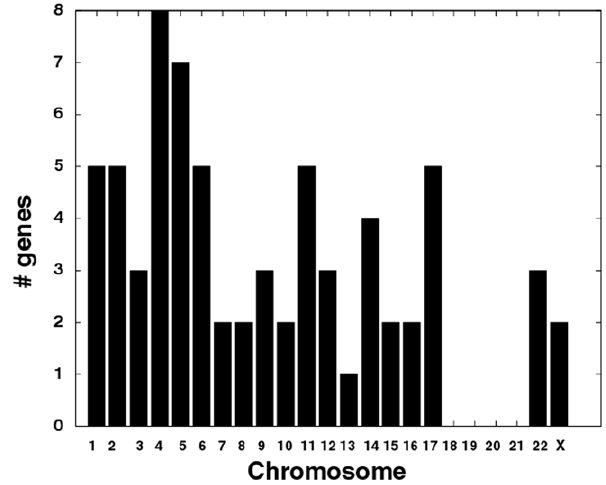
Figure 8. Bar chart for number of genes per chromosome. Genes are selected from Table S5 (n=75 genes).